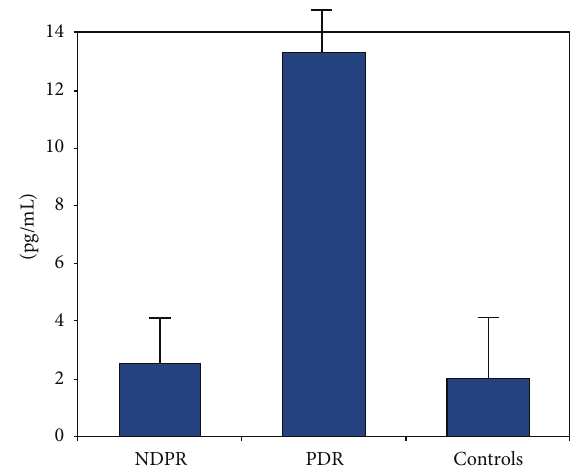
Figure 1: TNF-alpha levels in tears of the three different study groups. NPDR: non proliferative diabetic retinopathy; PDR: prolif- erativegroupdiabeticretinopathy.Thevaluesaregivenasmediaand standard